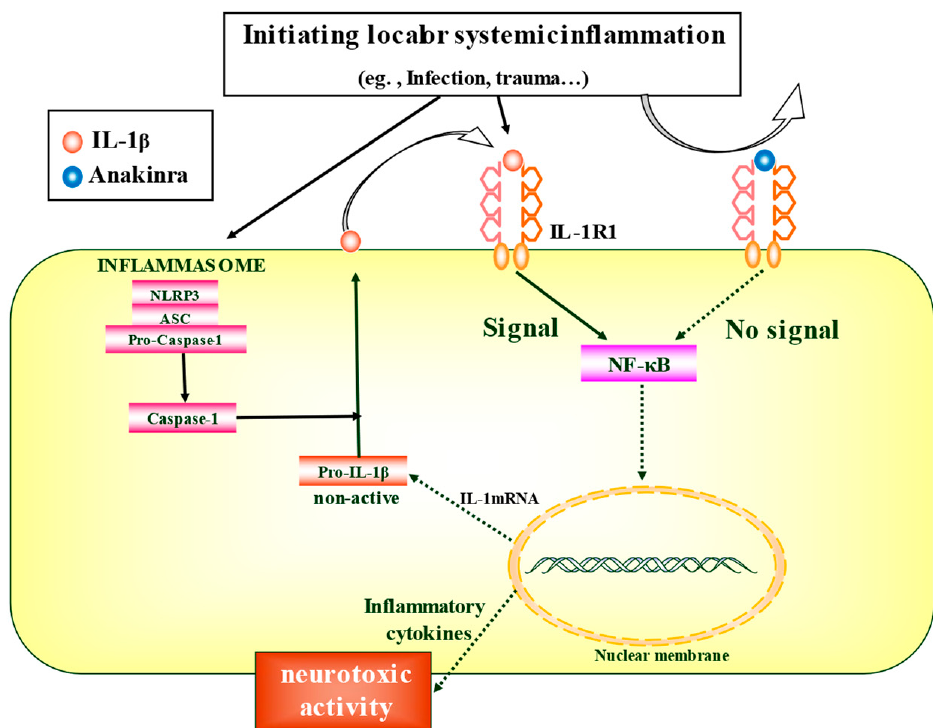
Figure 1. Mechanism of action of anakinra. Initiating local or systemic inflammation triggers, such as infections, can mediate the formation of the inflammasome, consisting of ASC, NLRP3 and pro- caspase-1. Pro-caspase-1 released by the formation of inflammasomes self-digests each other to become activated Caspase-1, which cleaves and matures the precursor of IL-1 β . The activation of IL-1 β though type I IL-1 receptor, which ultimately activates the transcription factor NF- κ B, which stimulates the production of inflammatory cytokines and leads to the inflammatory cascade. Ana- kinra blocks IL-1 receptor 1, antagonizing the effects of IL-1 β and exerts neuroprotective or anti- convulsant effects by blocking these neuroinflammatory cascades. ASC: apoptosis associated speck-like protein containing caspase activation and recruitment domain, IL: interleukin, IL-1-R1: NOD-Like Receptor containing pyrin domain interleukin-1 receptor 1, NF- κ B: nuclear factor kappa-light-chain-enhancer of activated B cells, NLRP3: NOD-Like Receptor containing pyrin domain 3.